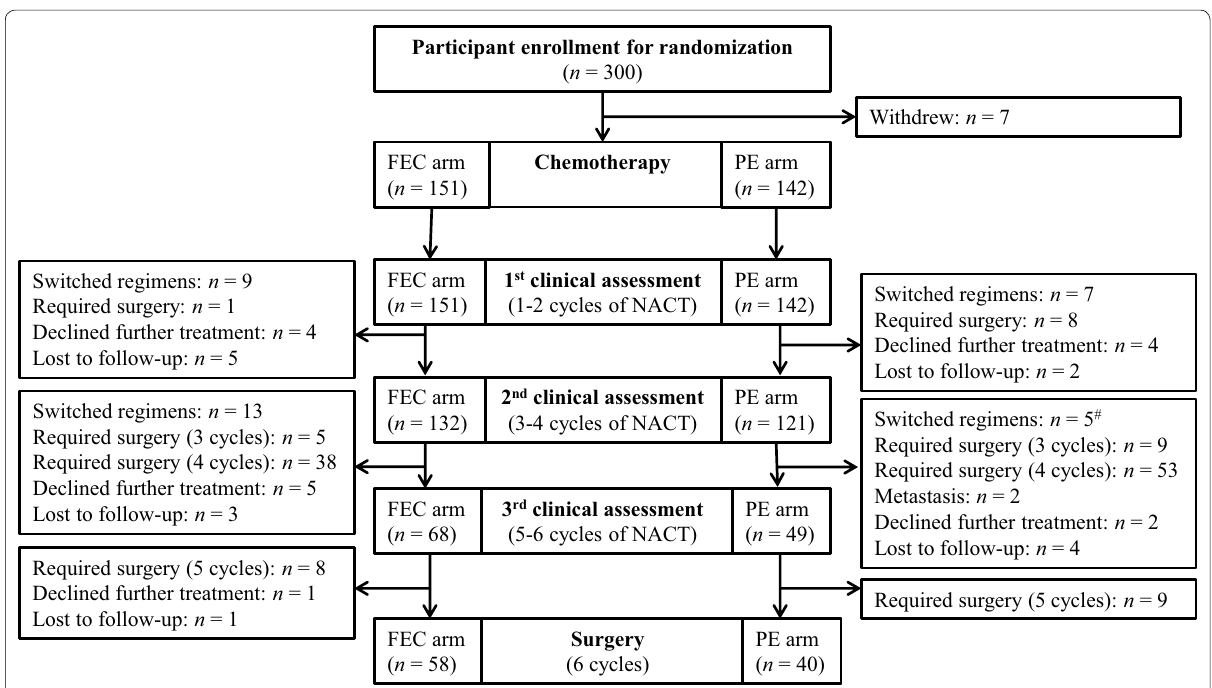
Fig. 1 Study flow chart for comparison of weekly PE and tri‑weekly FEC regimens in treating locally advanced breast cancer. FEC tri‑weekly 5‑fluo‑ rouracil–epirubicin–cyclophosphamide regimen, PE weekly paclitaxel–epirubicin regimen, NACT neoadjuvant chemotherapy. # All participants who switched chemotherapy regimens had undergone surgery except one in the PE arm that was lost to